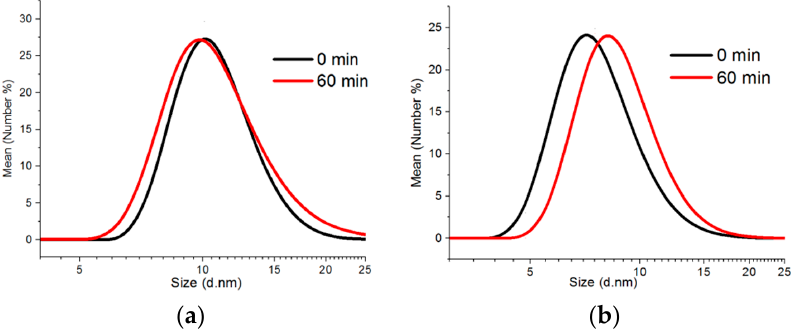
Figure 1. Size distribution diagrams of quantum dot (QD) samples collected when the temperature